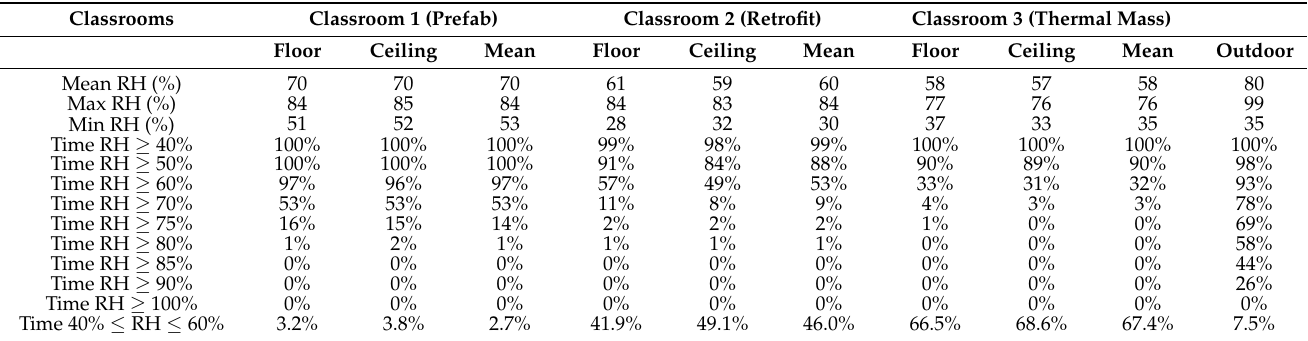
Table 6. Indoor mean relative humidity and pecentage of time related to different relative humidity ranges throughout winter (24 h per day).